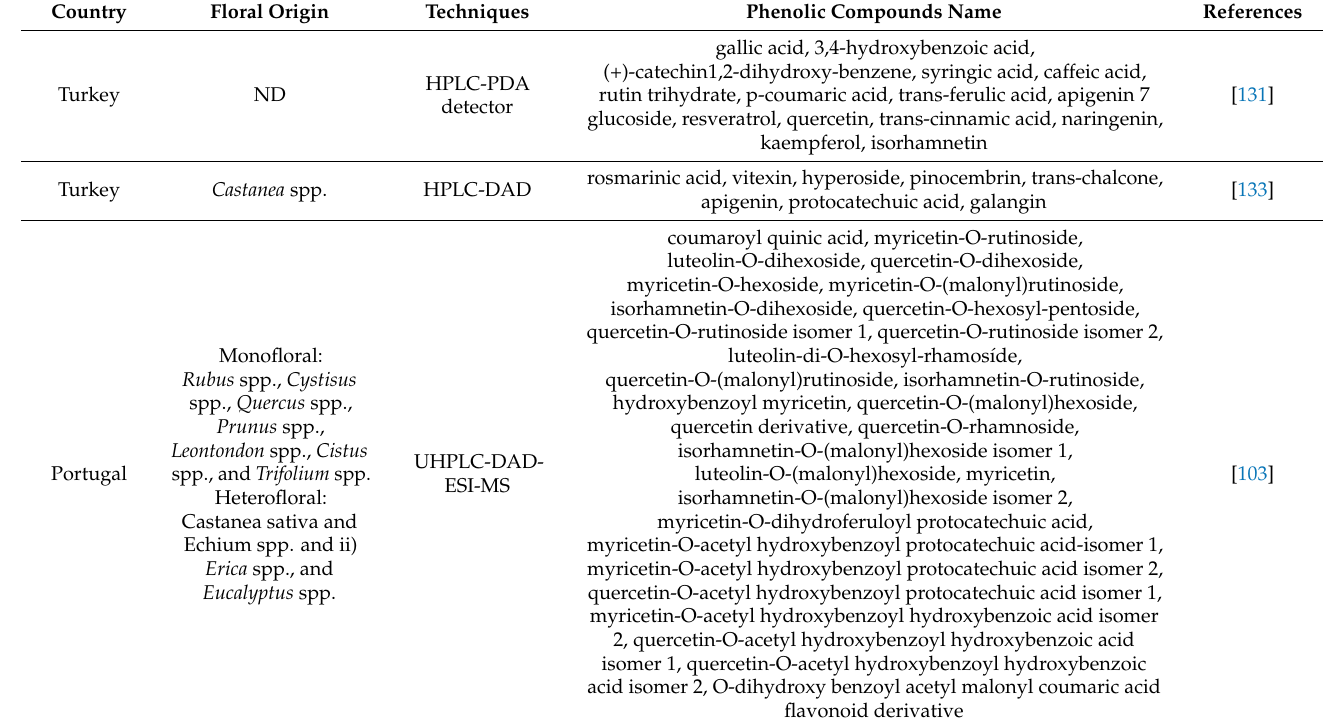
Table 2. Summary of the different methods used to determine the different active molecules of